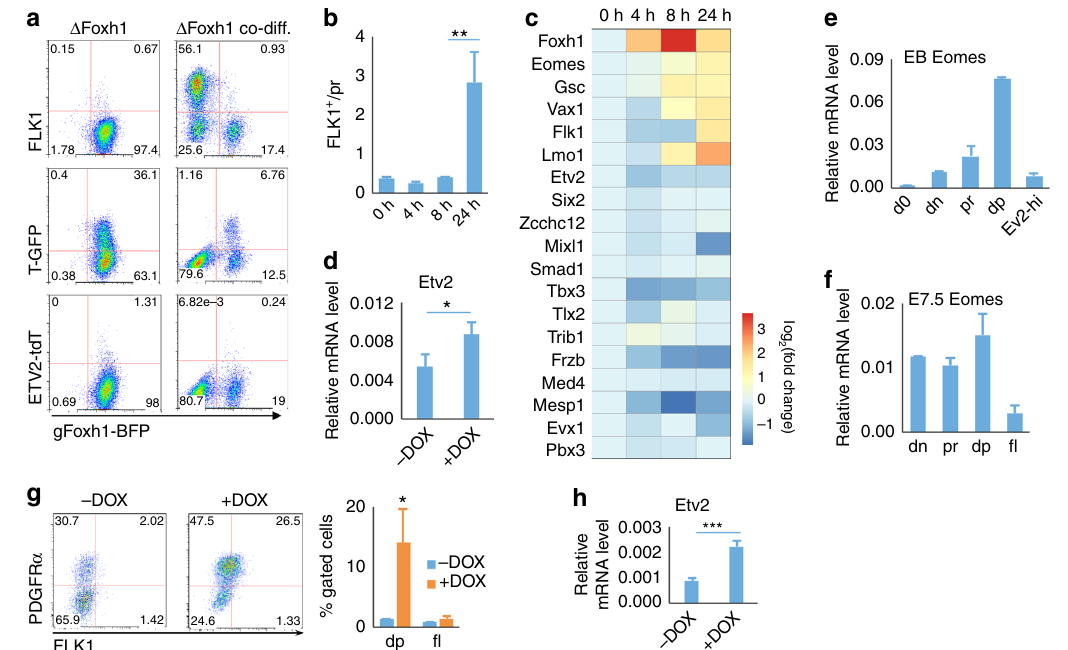
Fig. 5 Eomes functions downstream of Foxh1 in FLK1 + cell generation. a TGET Δ Foxh1 ES cells (BFP positive) were differentiated either by themselves ( left ) or with wild-type A2lox ES cells (BFP negative, right ). Subsequently, BFP-negative (wild type) or BFP-positive ( Δ Foxh1 ) cells were analyzed for FLK1, T-GFP, and Etv2-tdTomato expression on D4. b iFoxh1- Δ Foxh1 EB cells were treated with 500 ng/mL DOX for different time span as indicated and analyzed by fl ow cytometry on D3.5. c RT-qPCR analysis of indicated genes in D3.5 iFoxh1- Δ Foxh1 EB cells treated with 500 ng/mL DOX for different time span. Frzb and Smad1 , two signaling factors important for mesoderm development were included in the list. d RT-qPCR analysis of Etv2 was performed using iFoxh1- Δ Foxh1 ES cells differentiated with or without DOX (500 ng/mL, D2.5 – 3.5), and then for additional 1 day without DOX. e Eomes mRNA levels in indicated populations sorted from D3.5 TGET EBs and undifferentiated ES cells ( “ d0 ” ) are shown. f Eomes mRNA levels are shown in indicated populations sorted from E7.5 embryos. g Flow cytometry analysis of D3.5 iEomes- Δ Foxh1 EB cells treated with or without 50 ng/mL DOX for 24 h. h RT-qPCR analysis of Etv2 was performed using iEomes- Δ Foxh1 ES cells differentiated with or without DOX (50 ng/mL, D2.5 – 3.5), and then for additional 1 day without